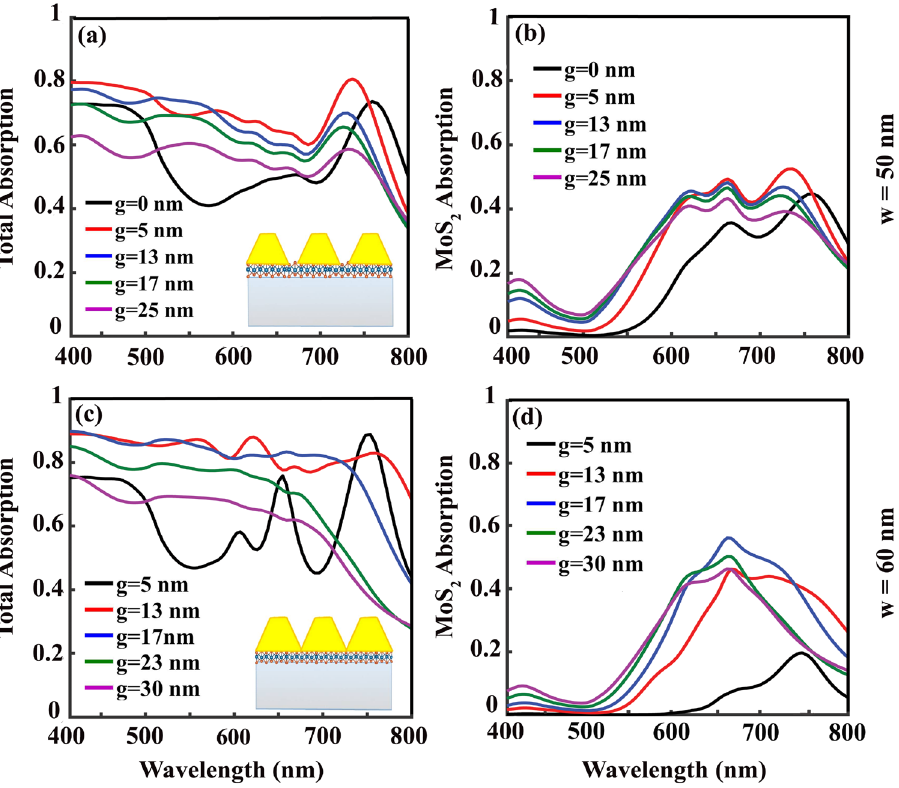
Figure 4. ( a )/( c ) Total and ( b )/( d ) MoS 2 absorption spectrum as a function of g , when the gold grating parameters are set to h = 110 nm, p = 60 nm, w = 50 nm/ w = 60